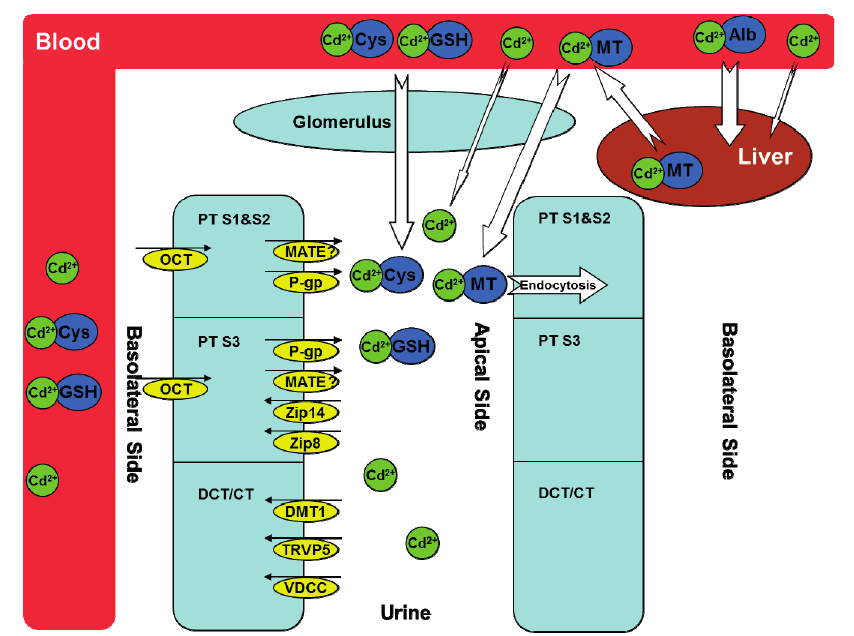
Figure 1. Cadmium transporters. Cadmium (Cd) is mostly bound to albumin in the circulation after absorption and then taken up by the liver. Some cadmium is bound to thiol-containing groups such as glutathione (GSH) and L -cysteine (Cys), which may be absorbed through both basolateral and apical sides of renal proximal tubular (PT)